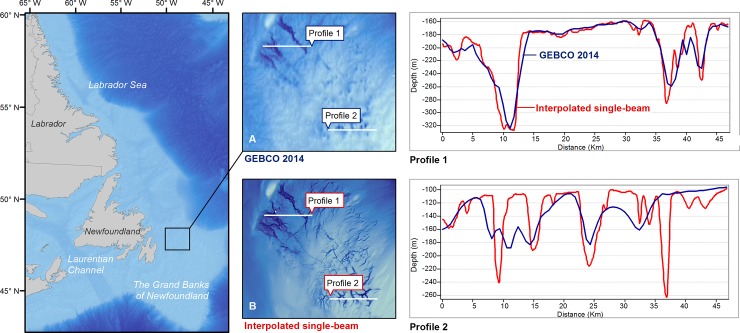
Bathymetric surfaces and horizontal depth profiles of tunnel valley systems on the Grand Banks of Newfoundland.(A) General Bathymetric Chart of the Oceans (approx. 930 x 630 m grid at this latitude) and (B) the interpolated bathymetry (75 x 75 m grid).